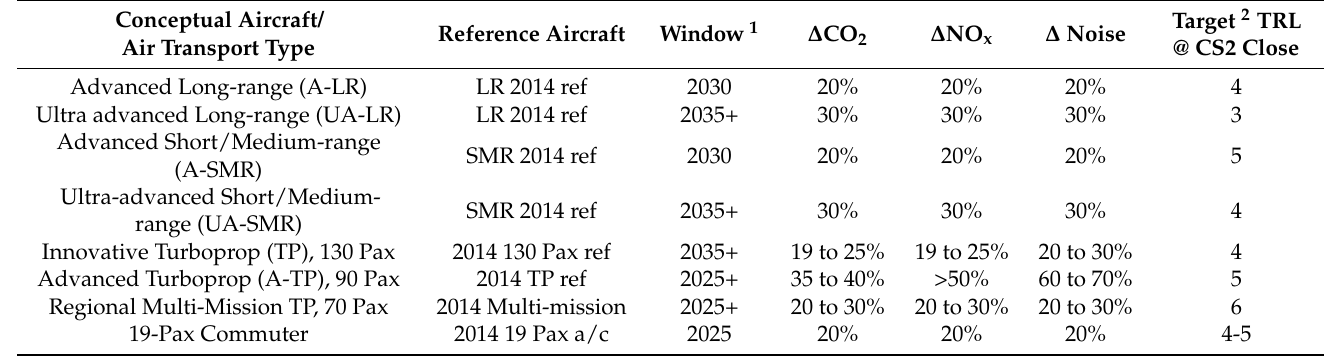
Table 4. Clean Sky 2 aircraft type and entry into